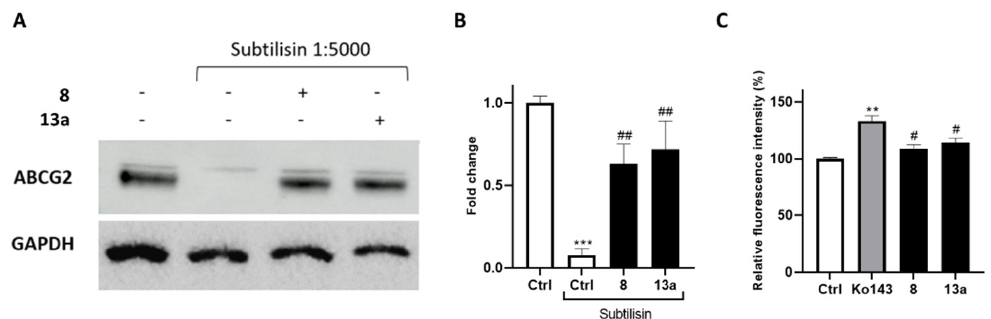
Figure 6. ( A ) lmmunoblotting analysis of the DARTS experiment revealing ABCG2 as the likely target of compounds 8 and 13a , together with its densitometric analysis ( B ). GAPDH is resistant to subtilisin under these experimental conditions and was used as a loading control. ( C ) Selectivity assay of compounds exhibiting a reduction in the fluorescence signal compared to the non-selective reference Ko143 in the calcein-AM assay. For each compound, three independent experiments were performed, and the standard deviation is expressed as error bars. **, *** denote p < 0.01 and p < 0.001, respectively, vs. the ctrl; #, ## denote p < 0.05 and p < 0.01, respectively, vs. the positive ctrl/Ko143.